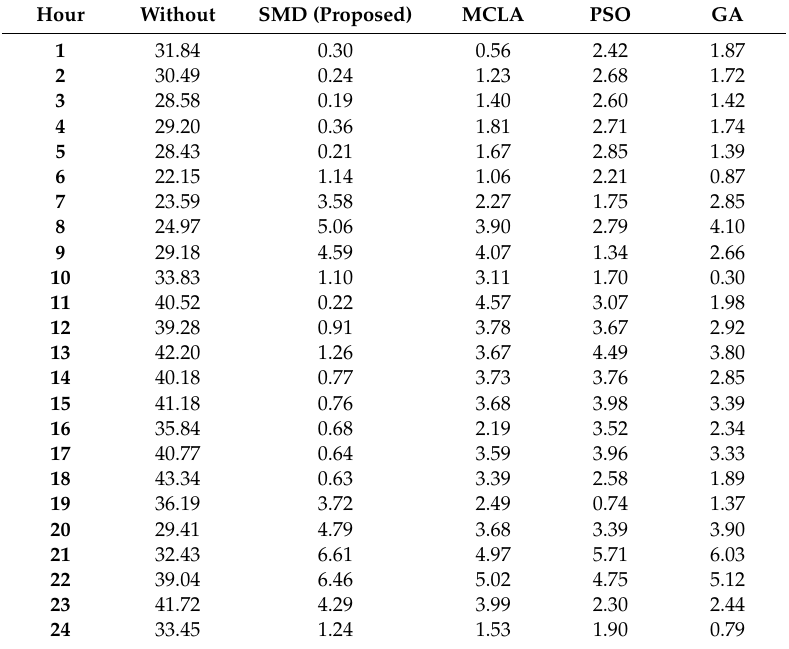
Table A3. Comparison between the hourly neutral currents calculated with di ff erent algorithms, the first branch (SP-Pillar